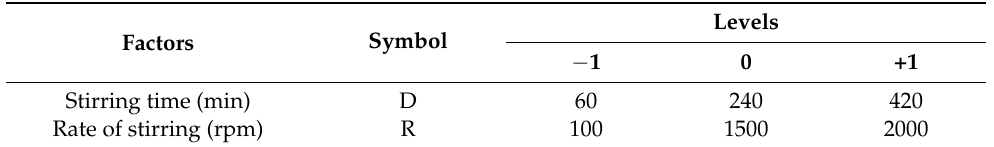
Figure 4. Contour plots showing the crossed effect of duration (D) and rate of stirring (R) on the retention rate (r) of cinnamon essential oil by GD-PPI-3 with the first sets of parameters ( A ) and the second one ( B ). Table 7. Factors and their levels selected for the second assay of Box–Behnken design (response surface methodology) for the GD-PPI-3/CAN EO encapsulation.